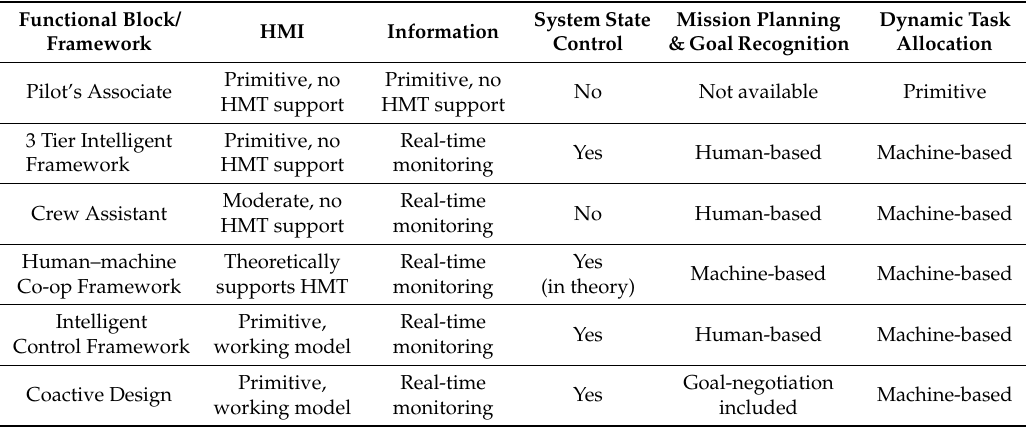
Table 1. Comparison of all six methods in inclusion of required